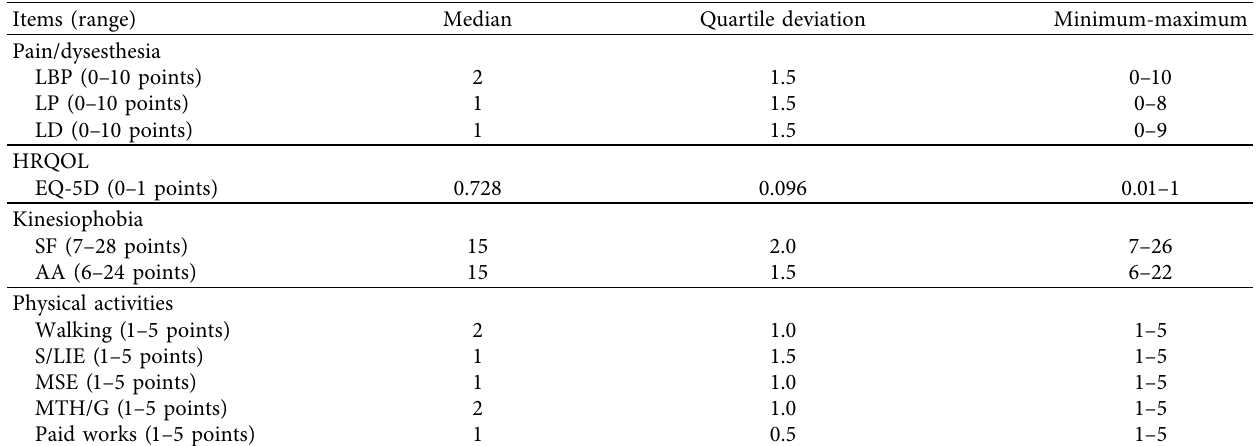
Table 1: Descriptive statistics of the assessed items.